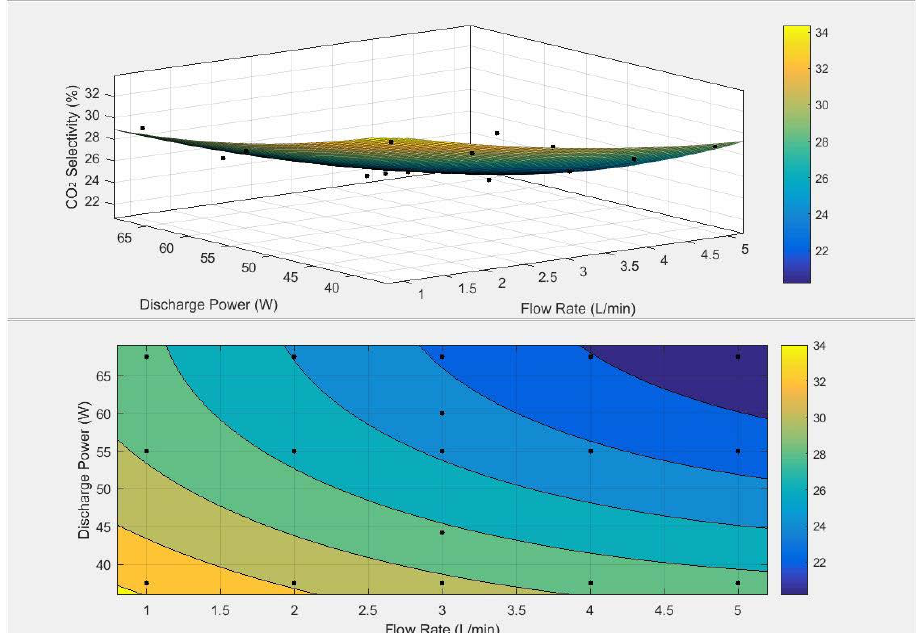
Figure 10. Effect of flow rate and discharge power on CO 2 selectivity of chlorobenzene in the Cu/γ -Al 2 O 3 reactor.